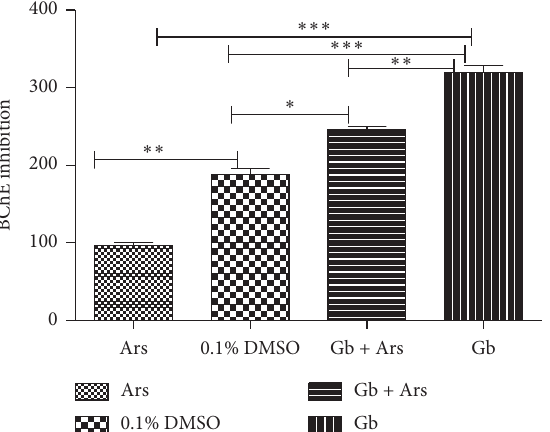
Figure 5: Total protein assay of adult Javanese medaka treated with arsenic, crude extract, and arsenic and crude extract. The per- centage of total protein is shown versus concentration of the tested sample (arsenic, crude extract, and crude extract and arsenic). ∗ P < 0 . 001 represents significant different values of the control group and group exposed to arsenic only, crude extract and arsenic, and crude extract only. The values represent mean ± SD from three ( n � 3) independent experiments.